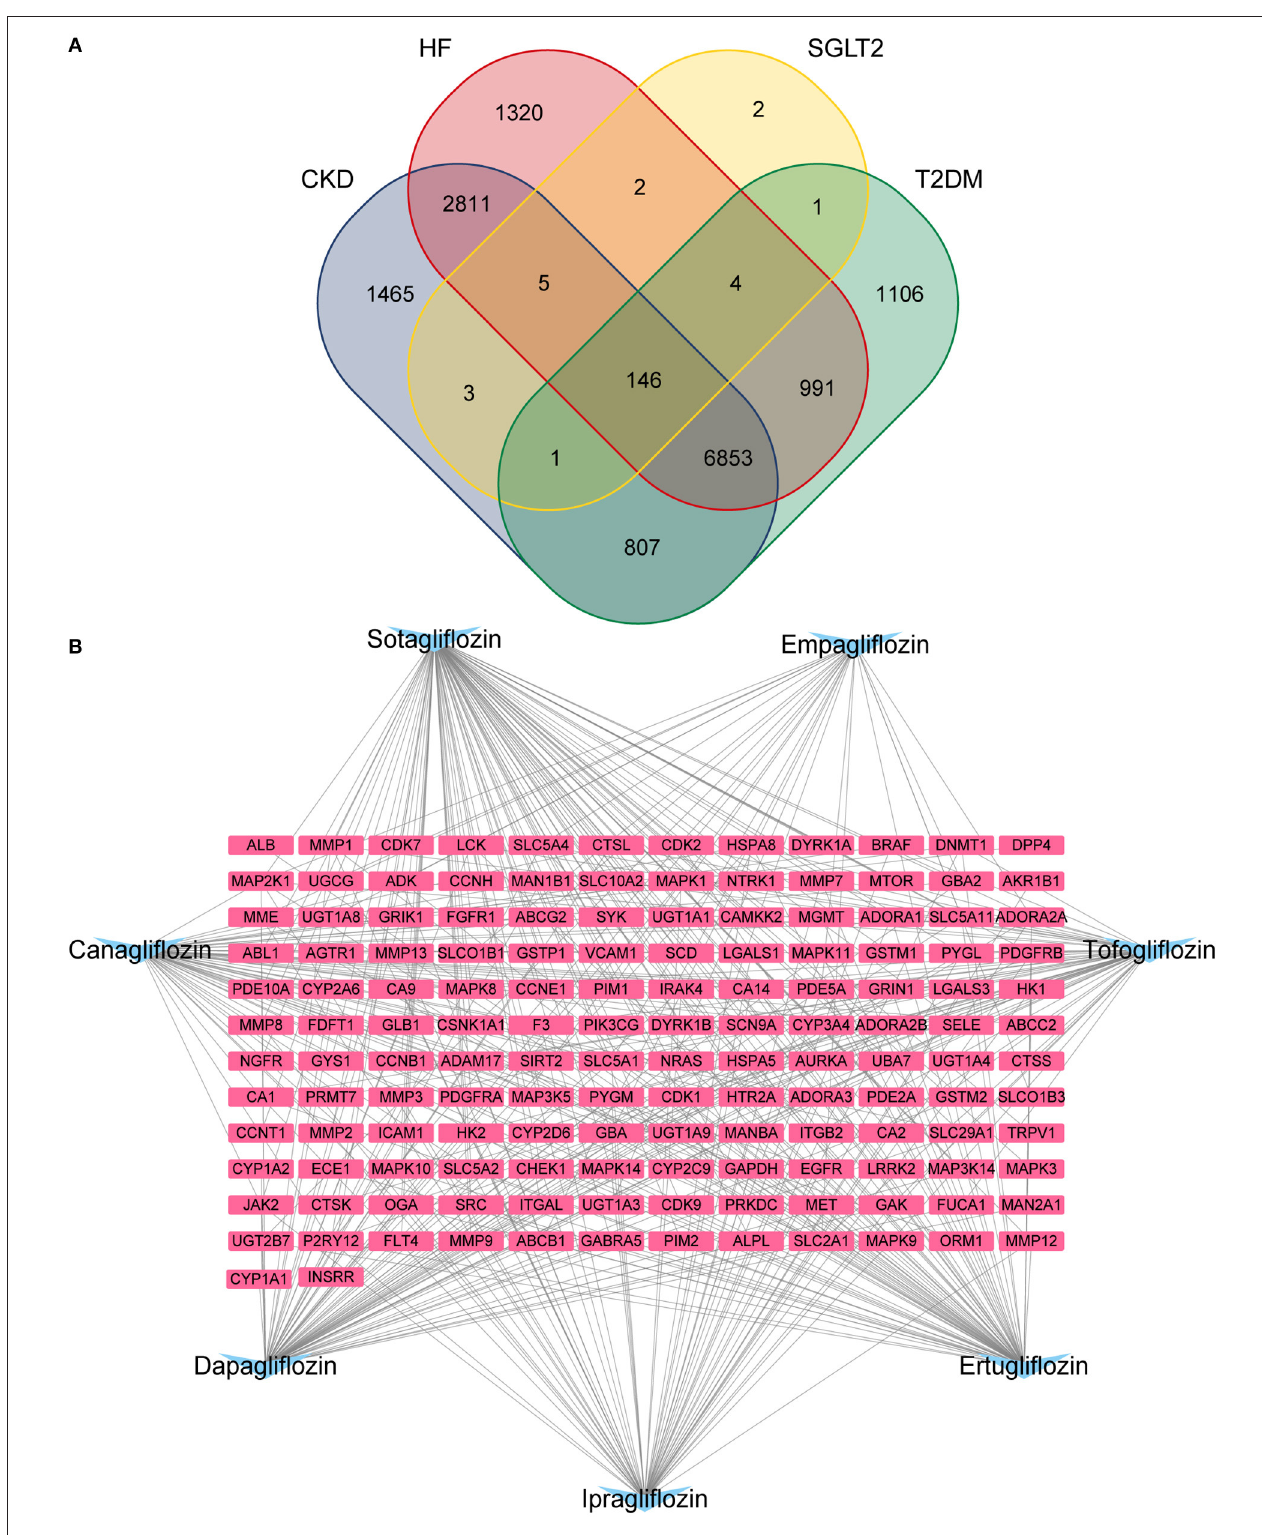
FIGURE 1 | Potential SGLT2 inhibitors-related targets. (A) Venn diagram showing that 146 targets were common to CKD, HF, SGLT2, and T2DM; (B) Interaction network to indicate drugs-targets composited of SGLT2 inhibitors (blue) and 146 targets (pink).